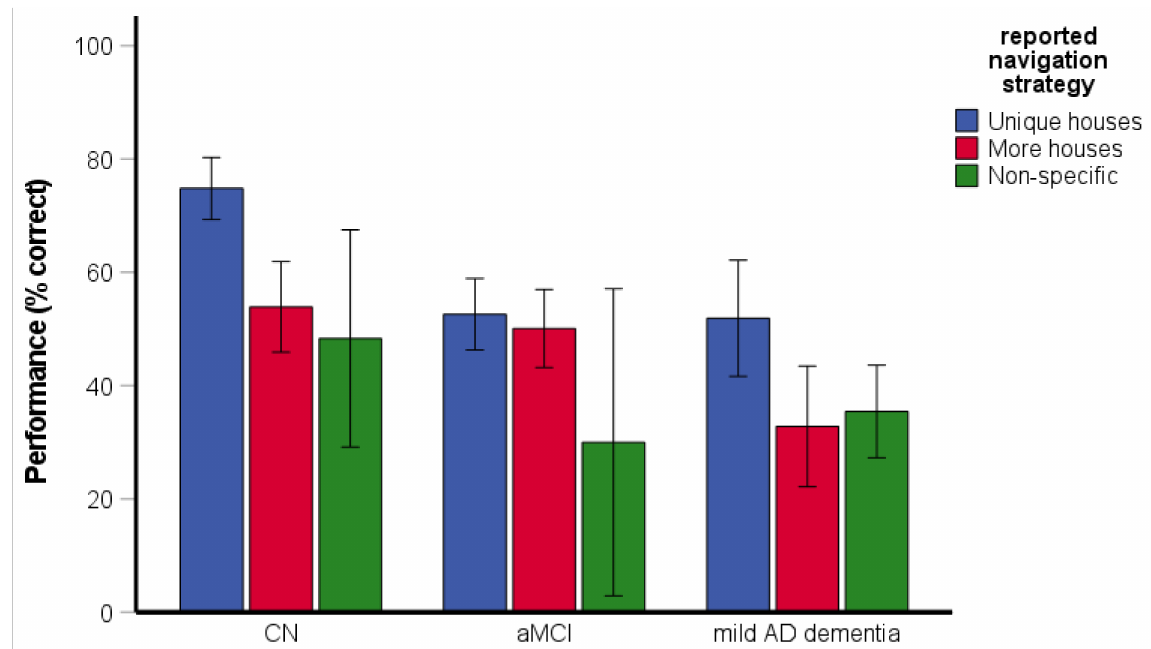
Figure 9. Directional-approach task—the effect of reported strategy on spatial navigation performance. CN, cognitively normal; aMCI, amnestic mild cognitive impairment; mild AD dementia, mild Alzheimer’s disease